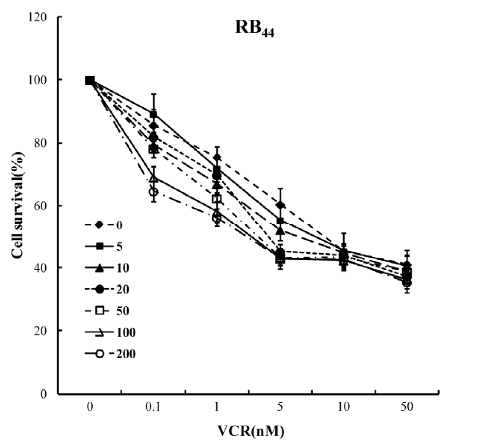
Figure 2. Cytotoxicity of VCR on HXO-RB cells with or without addition of adenovirus 44 under different treatments; ( B ) for HXO-RB (SG600). ( A ) Cell viability of HXO-RB 44 cells, IC values for VCR were changed in the different SG600 treatment groups. The 50 results are representative of three independent experiments and of four replicates in each experiment. * p < 0.05, ** p < 0.01 relative to the SG600 (MOI = 0) treatment group. IC : concentration of drug that is lethal for 50% of cells. 50